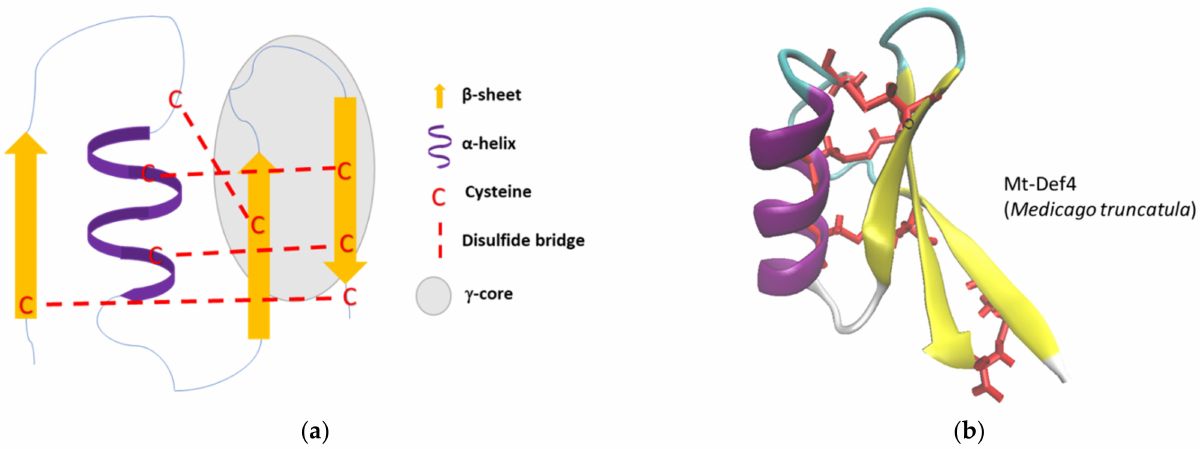
Figure 3. Representation of the cysteine-stabilized alpha-beta (CS αβ ) motif present in the structure of plant and of some invertebrate defensins: ( a ) schematic representation of the CS αβ motif present in the plant defensin Mt-Def4; ( b ) schematic representation of the tridimensional structure of the plant defensin Mt-Def4. PDB: 2LR3 from M. truncatula . The colors in the figure represent α -helix (purple), β -sheets (yellow), turns (blue) and disulfide bridges (red). The structures were visualized